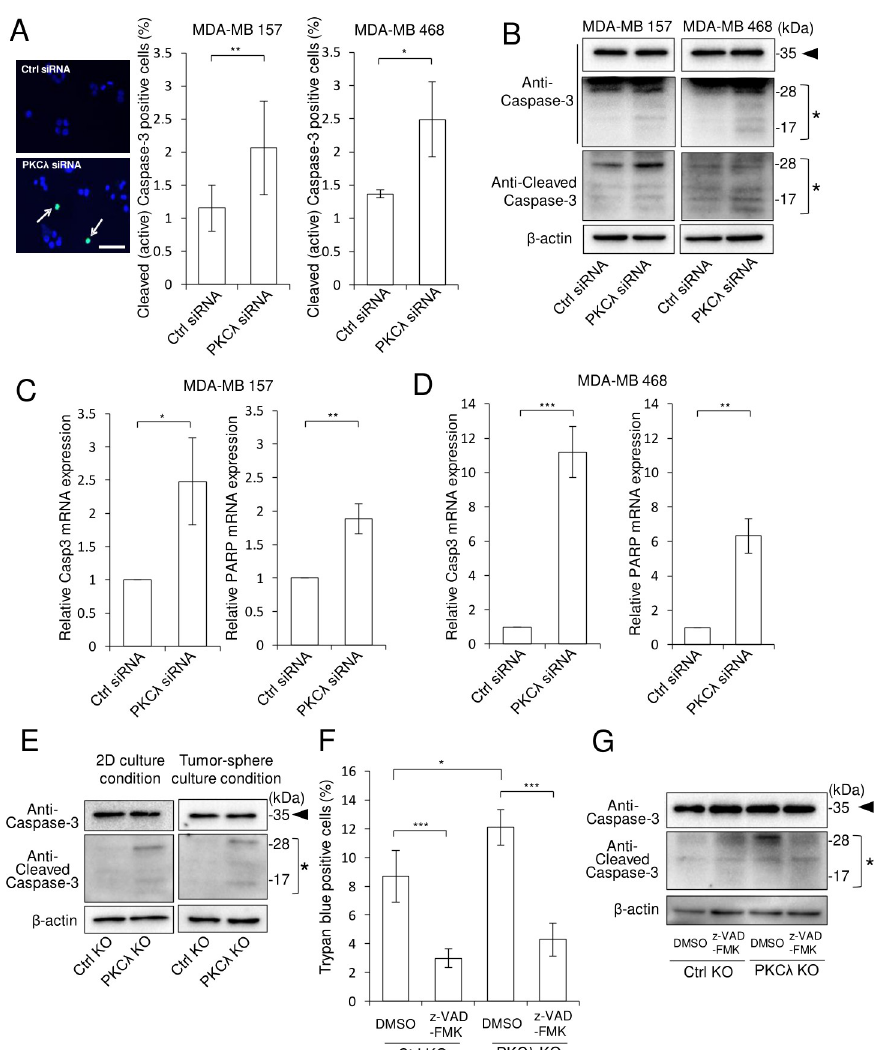
Fig 4. PKC λ depletion leads to apoptosis in ALDH1 high cells. (A) Numbers of cleaved (active) caspase-3-positive ALDH1 high MDA-MB 157 cells 72 h after PKC λ siRNA transfection (left, representative immunofluorescent staining of cleaved (active) caspase-3 (green) and Hoechst 33342 staining (blue); right, quantitative values). � p < 0.05, �� p < 0.01 Student’s t-test. Scale bar; 100 μ m. (B) Immunoblot analysis of intact and cleaved caspase-3 in ALDH1 high MDA-MB 157 (left) and MDA-MB 468 (right) cells 48 h after PKC λ siRNA transfection of ALDH1 high cells. β -actin was used as an internal control. (C-D) Quantitative PCR analysis of Casp3 and PARP in ALDH1 high cells isolated from MDA-MB 157 (C) and MDA-MB 468 (D) 48 h after PKC λ siRNA transfection. � p < 0.05, �� p < 0.01, ��� p < 0.001, Student’s t-test. (E) Immunoblot analysis of intact and cleaved caspase-3 in ALDH1 high control or MDA-MB 157 PKC λ KO cells under 2D (left) and tumor-sphere culture condition (right). β -actin was used as an internal control. (F) Trypan blue assays in ALDH1 high control and MDA-MB 157 PKC λ KO cells after incubation with 0.5% DMSO (control) or 100 μ M z-VAD-FMK for 48 h. � p < 0.05, ��� p < 0.001, Tukey’s test. (G) Immunoblot analysis of intact and cleaved caspase-3 in ALDH1 high control or MDA-MB 157 PKC λ KO cells after incubation with 0.5% DMSO (control) or 100 μ M z-VAD-FMK for 48 h. The arrowheads mark intact Caspase-3, and asterisks mark Cleaved Caspase-3. Data depict the mean ± SD (three independent experiments). ALDH1 low cells. PKC λ KD led to accumulation of ROS in ALDH1 high cells derived from MDA-MB 157 and MDA-MB 468, but led to reductions in ROS levels in ALDH1 low MDA-MB 157 cells but not MDA-MB 468 cells (Fig 6B and 6D). In addition, we proposed that depletion PKC λ may lead to enhanced expression of ROS defense genes, including SOD1, SOD2 and